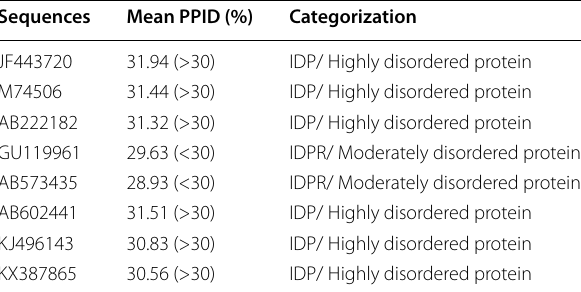
Table 3 Categorization of the disorder variant of the HEV ORF2